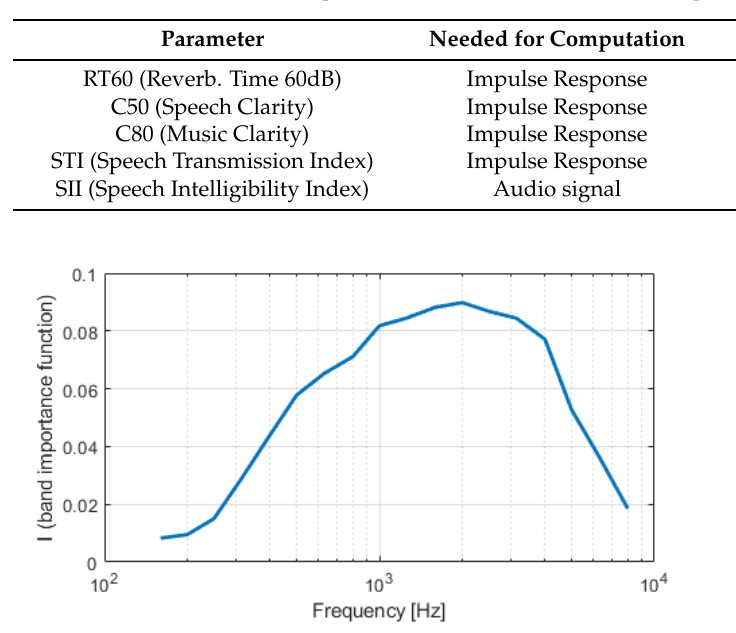
Table 1. A set of room acoustic parameter, the source needed for computation and regulation if any.